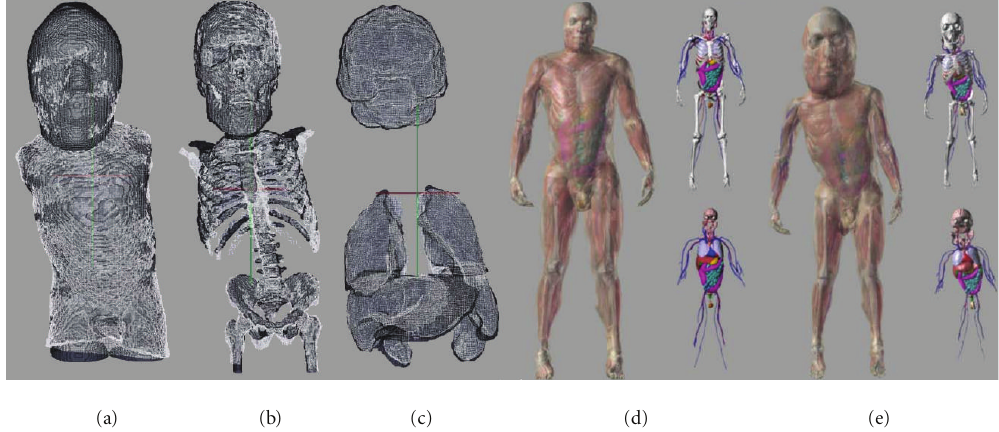
Figure 6: Triangulated surfaces from an example deformed adult template (white) and target child (black) are of (a) body, (b) bones, and (c) other organs. Adult male XCAT phantom is shown in (d), and an example custom dosimetry phantom is shown in (e).